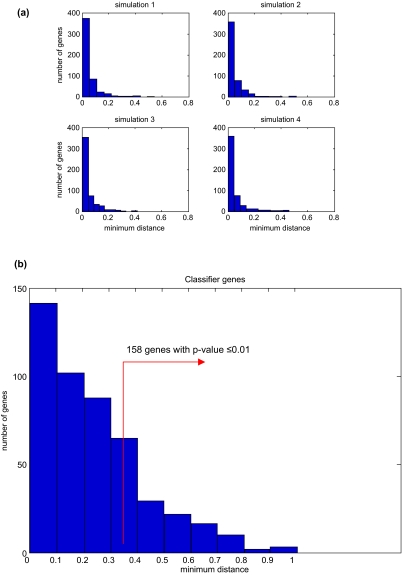
(a) The minimum distances of randomly formed expression profiles in four simulations are shown as representative of other simulations. The x-axis is the minimum distance and y-axis is the number of genes having that distance. (b) The distribution of minimum distances for 466 genes. 158 of these genes have minimum distances with p-values ≤0.01, hence identified as significant single gene biomarkers.